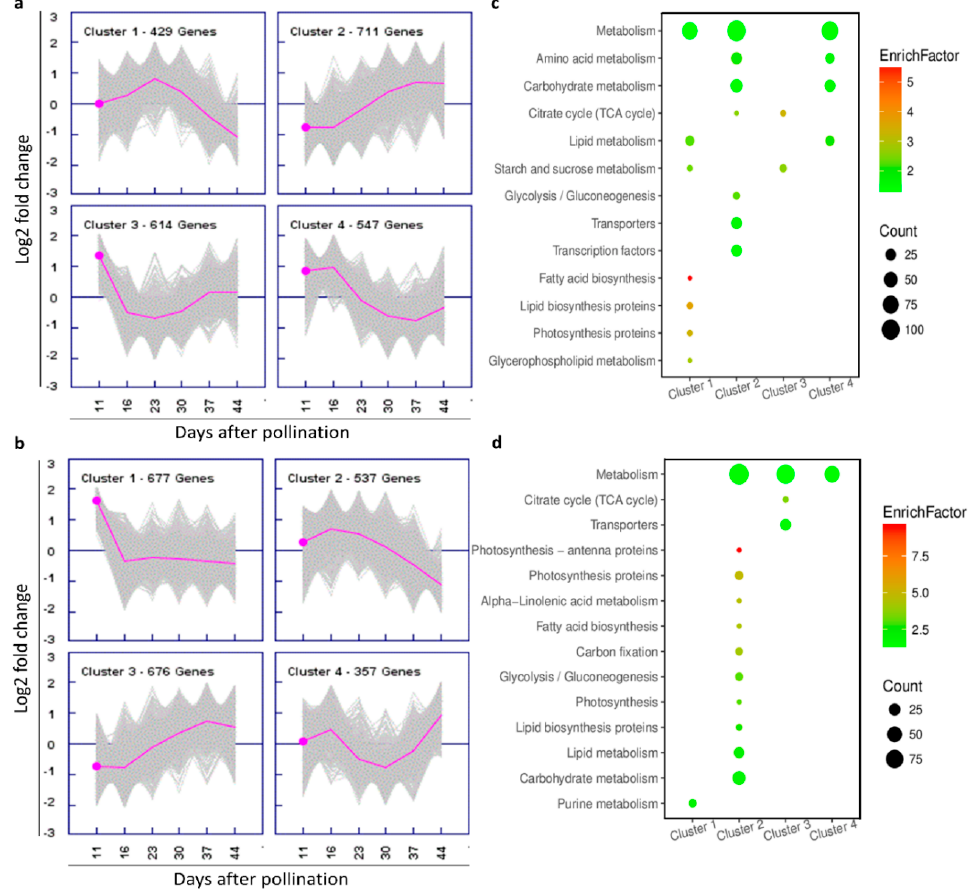
Figure 7. Cluster analysis of seed and SW DEGs. Four clusters in each tissue were identified by Genesis based on K-means clustering adjusted with normalized gene log2 fold change value. The y-axis represents normalized gene log2 fold change value. ( a ) DEG cluster expression in the seed. ( b ) DEG cluster expression in silique wall. ( c ) Kyoto Encyclopedia of Genes and Genomes (KEGG) analysis of genes in seed clusters. ( d ) KEGG analysis of genes in SW clusters (only highly enriched, most relevant KEGG pathways are shown here). (Gene number ≥ 5 and p -value ≤ 0.05.) Enrichfactor refers to the ratio of differential genes in a cohort group compared with the ratio in the database. Similar to cluster 3 in seed, DEGs of cluster 1 in SW experienced a sharp downregulation at the first two stages and then turned to a steady level (Figure 7b1). Clusters 2 and 3 in SW exhibited similar patterns to clusters 1 and 2 in seed, respectively (Figure 7b). In SW cluster 4, DEGs were upregulated slightly at first and downregulated to the bottom at 30 DAP followed by a sharp upregulation (Figure 7b).